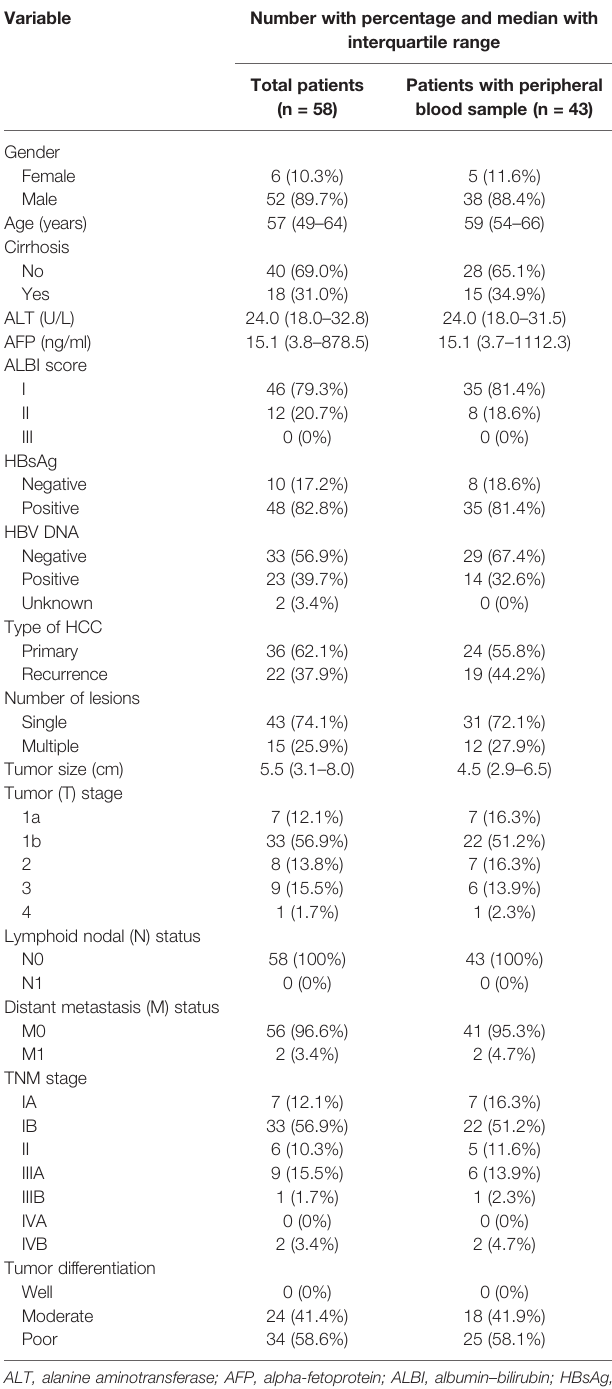
TABLE 1 | The baseline characteristics of HCC patients. Variable Number with percentage and median with